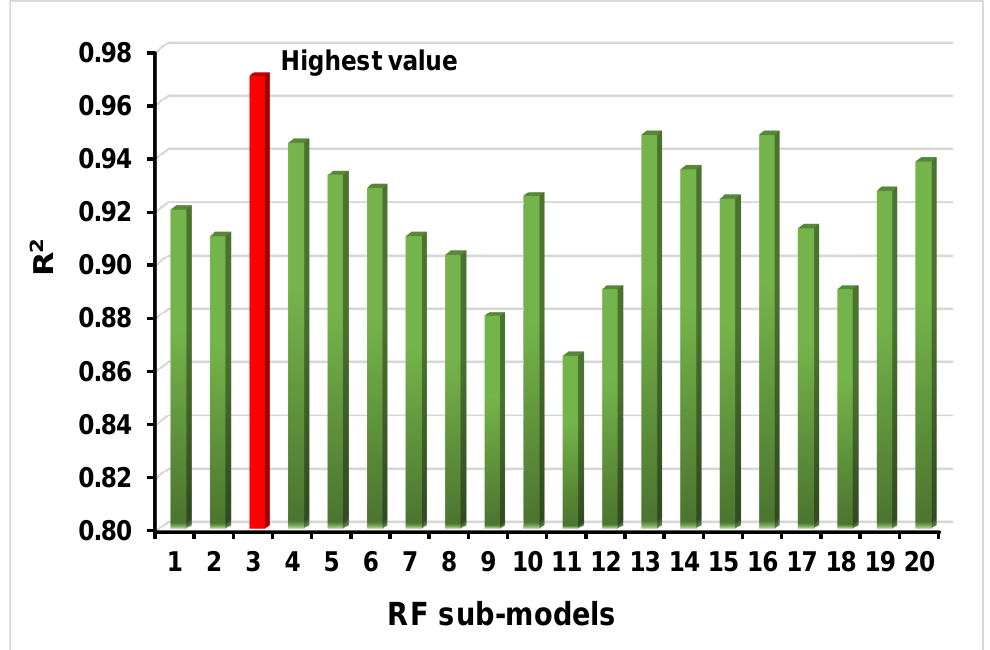
Figure 16. Results of RF sub-models indicating the values for every model ’ s significance level.